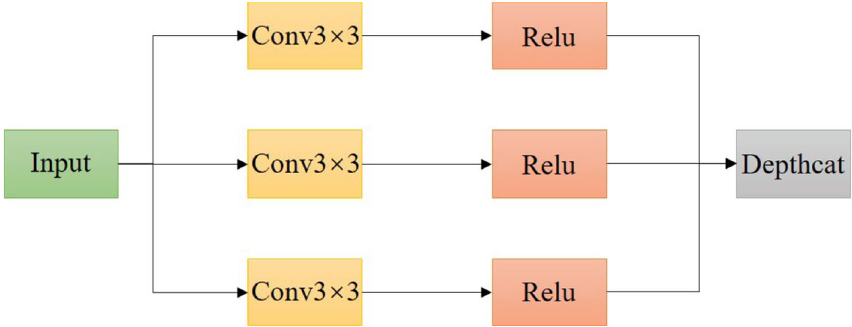
Figure 5. Conv5 structure